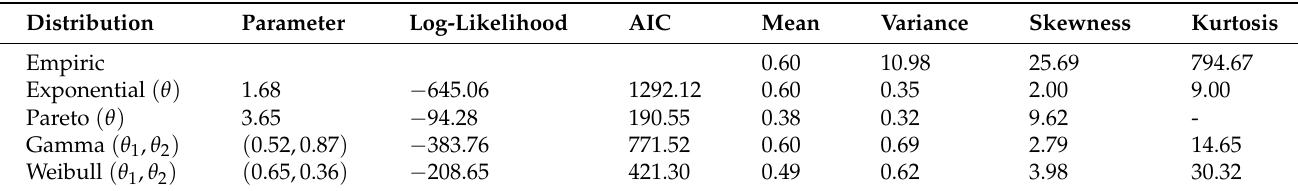
Table 2. The parameter estimates for several parametric distributions based on the empirical claim data along with the comparison of the estimates for their four (central)